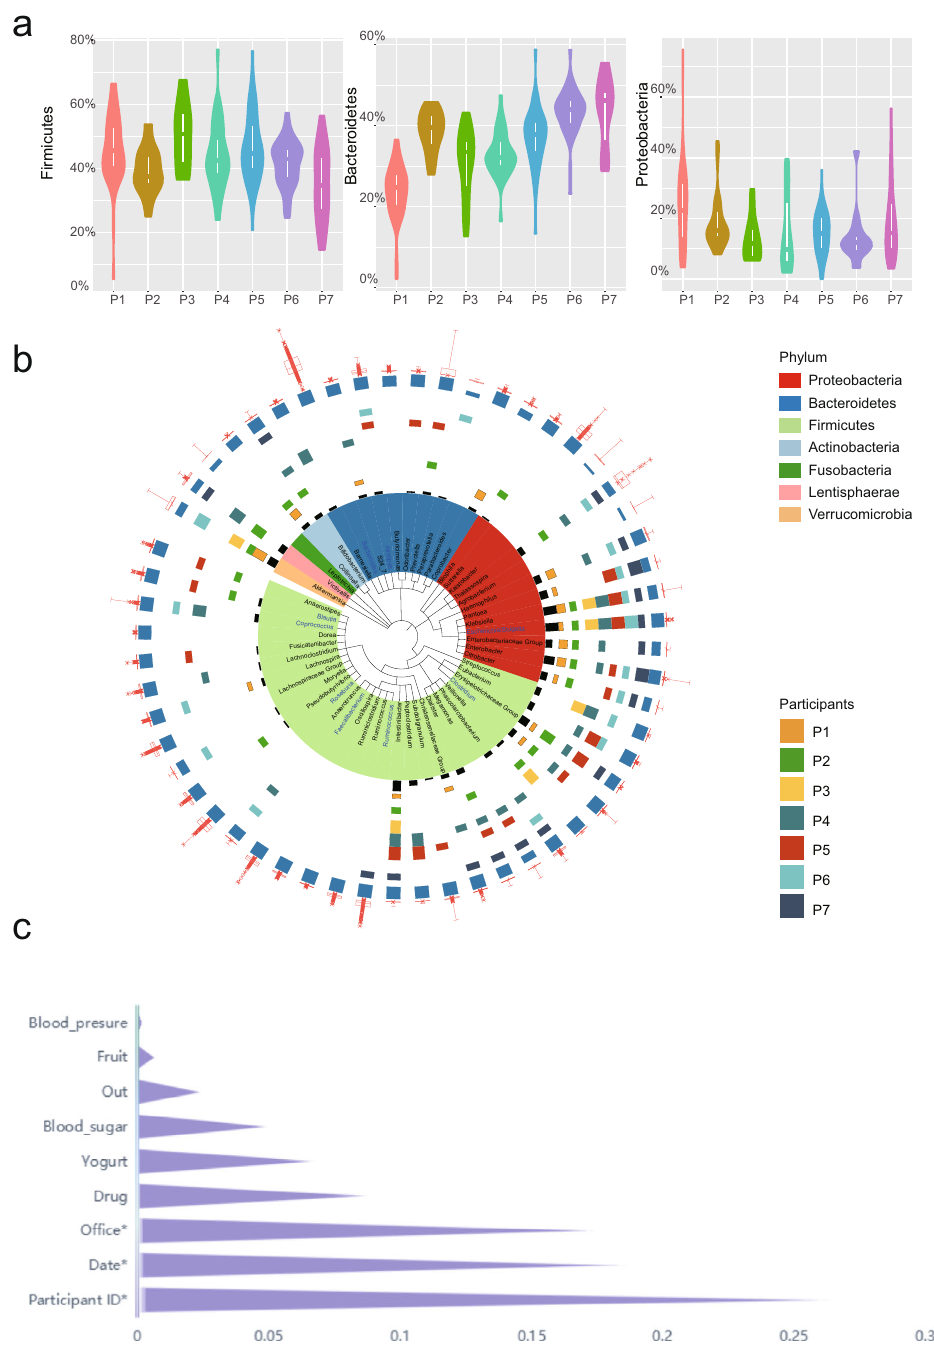
Fig. 3 Differences in gut microbiota bacterial composition. a Violin plots presenting the abundances of Firmicutes, Bacteroidetes, and Proteobacteria in fecal samples obtained from the seven participants. P, participant. b Taxonomy tree of 58 genera identi fi ed in this study. Three bar charts from inside to outside show the total number of short-term blooms (Black bar chart), the number of short-term blooms in 7 participants (P1-P7) and the percentage of samples in which genus was detected in this study (Blue bar chart). The outermost red box plot shows the relative abundance of each genus in all samples. Boxplots display the distribution of data based on the fi ve number summary: minimum, fi rst quartile, median, third quartile, and maximum. General labeled in blue text are core genera identi fi ed in all samples. The background color represents the phylum. c Scores corresponding to the in fl uence of nine factors (participant ID, date, workspace/of fi ce, drug use, yogurt consumption, fruit consumption, travelling abroad history, blood pressure, and blood sugar) on gut microbiota composition over